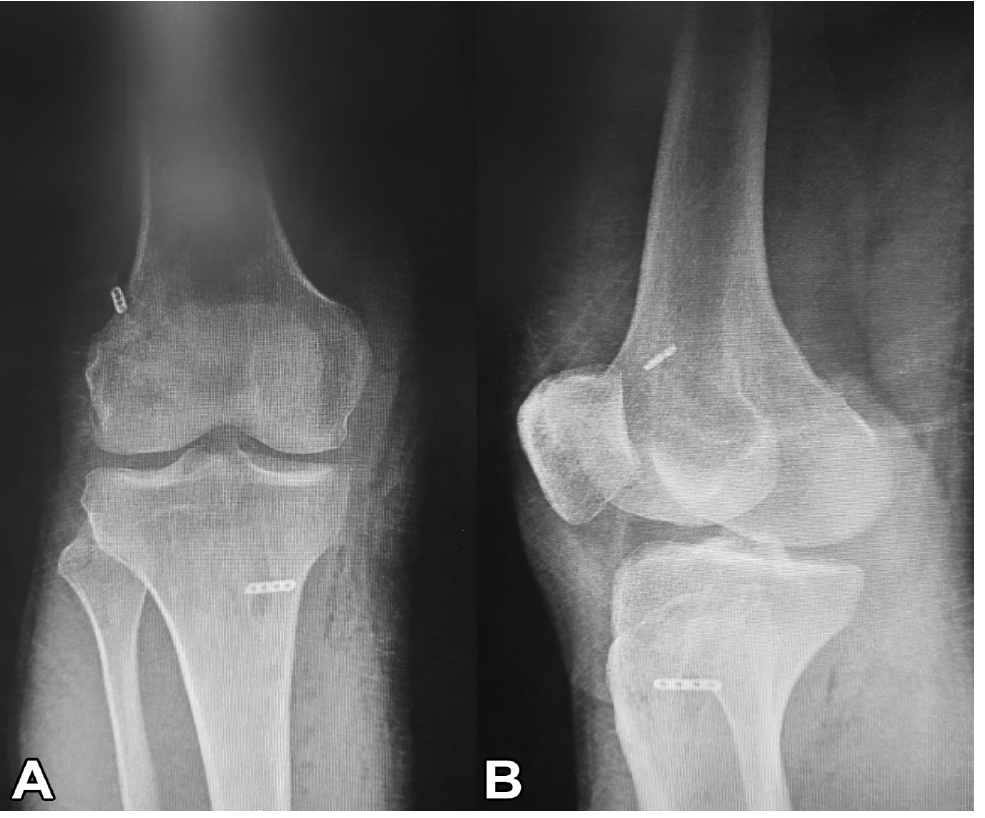
Figure 3. Post ‐ operative roentgenography showing the use of the materials. ( A ) Post ‐ operative roentgenography showing the use of Femobutton plus Lift Loop external. ( B ) Post ‐ operative roentgenography shows three materials, Endobutton CL, Ultrabutton þ, and Xtendobutton in combination.